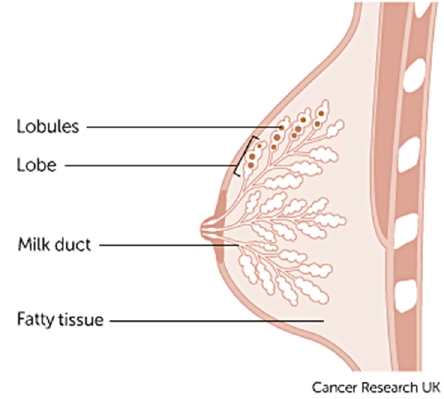
Figure 3. Anatomy of the breast credits to Cancer Research UK [9].